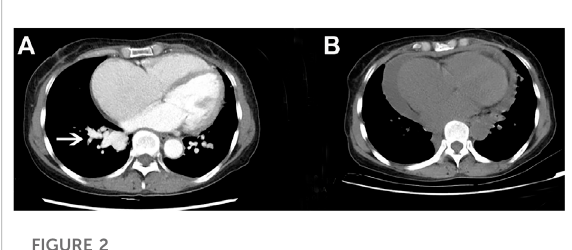
FIGURE 2 Comparison of chest CT before and after the operation. (A) Chest-enhanced CT showed an enhanced vascular mass in the lower part of the right pulmonary artery (white arrow) before operation. (B) Plain CT scan of the chest revealed that the former vascular mass had disappeared after the